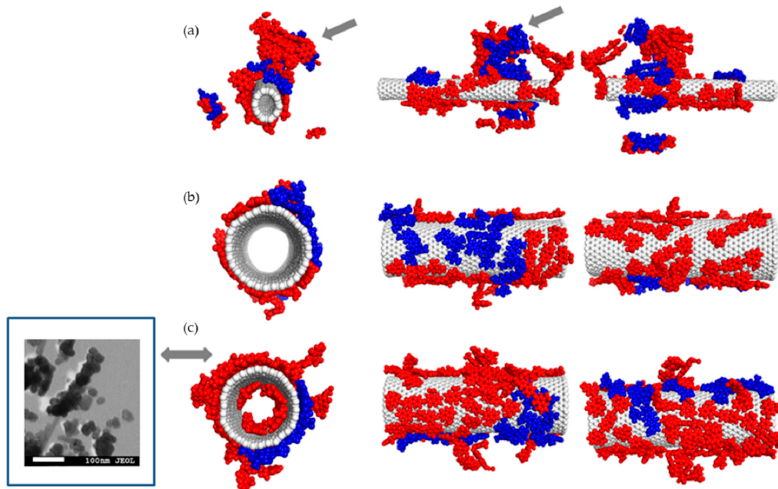
Figure 5. The structure of SWNT-CR-DOX systems at neutral pH values. ( a ) system composed of SWNT (10.0), 20 CR molecules (red) and 10 DOX molecules (blue), arrows show partial incorporation of DOX into supramolecular CR structure; ( b ) system composed of SWNT (30.0), 20 CR molecules and 10 DOX molecules; ( c ) system composed of SWNT (30.0), 40 CR molecules and 10 DOX molecules. Ionic strength of the solution was 0.145 M. Inset: scanning electron microscope photograph of nanotube (10 nm wide) with CR-DOX complex bound to the surface (concentration of CR = 1 mg/mL).